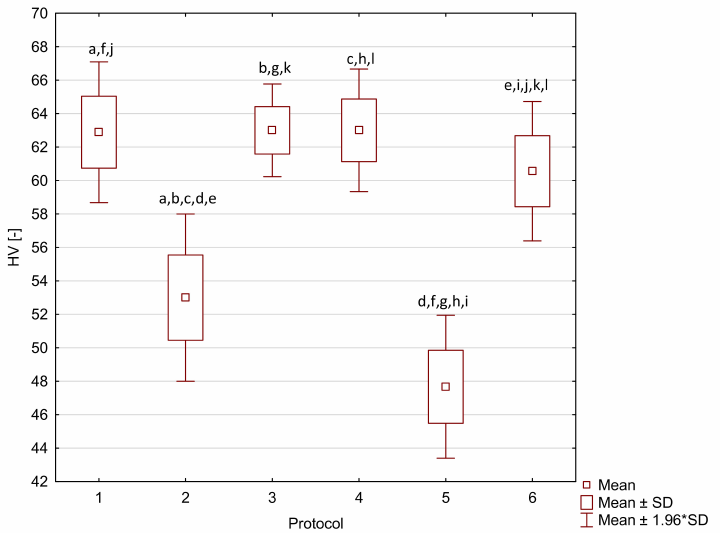
Figure A9. Box-and-whisker plot of Vickers hardness (HV) of Arkon material. Statistically-significant differences were detected between the following: (a,b,c,d,e) Protocol 2 (artificial saliva, 90 days, 37 ◦ C) vs. (a) Protocol 1 (water, 24 h, 37 ◦ C) ( p = 0.000000); (b) Protocol 3 (water, 500 thermocycles, 5/55 ◦ C) ( p = 0.000000); (c) Protocol 4 (water, 7500 thermocycles, 5/55 ◦ C) ( p = 0.000000); (d) Protocol 5 (0.1 M NaOH, 7 days, 60 ◦ C) ( p = 0.000002); (e) Protocol 6 (water, 5 days, 55 ◦ C) ( p = 0.000000); (f,g,h,i) Protocol 5 (0.1 M NaOH, 7 days, 60 ◦ C) vs. (f) Protocol 1 (water, 24 h, 37 ◦ C) ( p = 0.000000); (g) Protocol 3 (water, 500 thermocycles, 5/55 ◦ C) ( p = 0.000000); (h) Protocol 4 (water, 7500 thermocy- cles, 5/55 ◦ C) ( p = 0.000000); (i) Protocol 6 (water, 5 days, 55 ◦ C) ( p = 0.000000); (j,k,l) Protocol 6 (water, 5 days, 55 ◦ C) vs. (j) Protocol 1 (water, 24 h, 37 ◦ C) ( p = 0.021185); Protocol 3 (water, 500 thermocycles, 5/55 ◦ C) ( p = 0.016035); (l) Protocol 4 (water, 7500 thermocycles, 5/55 ◦ C) ( p =